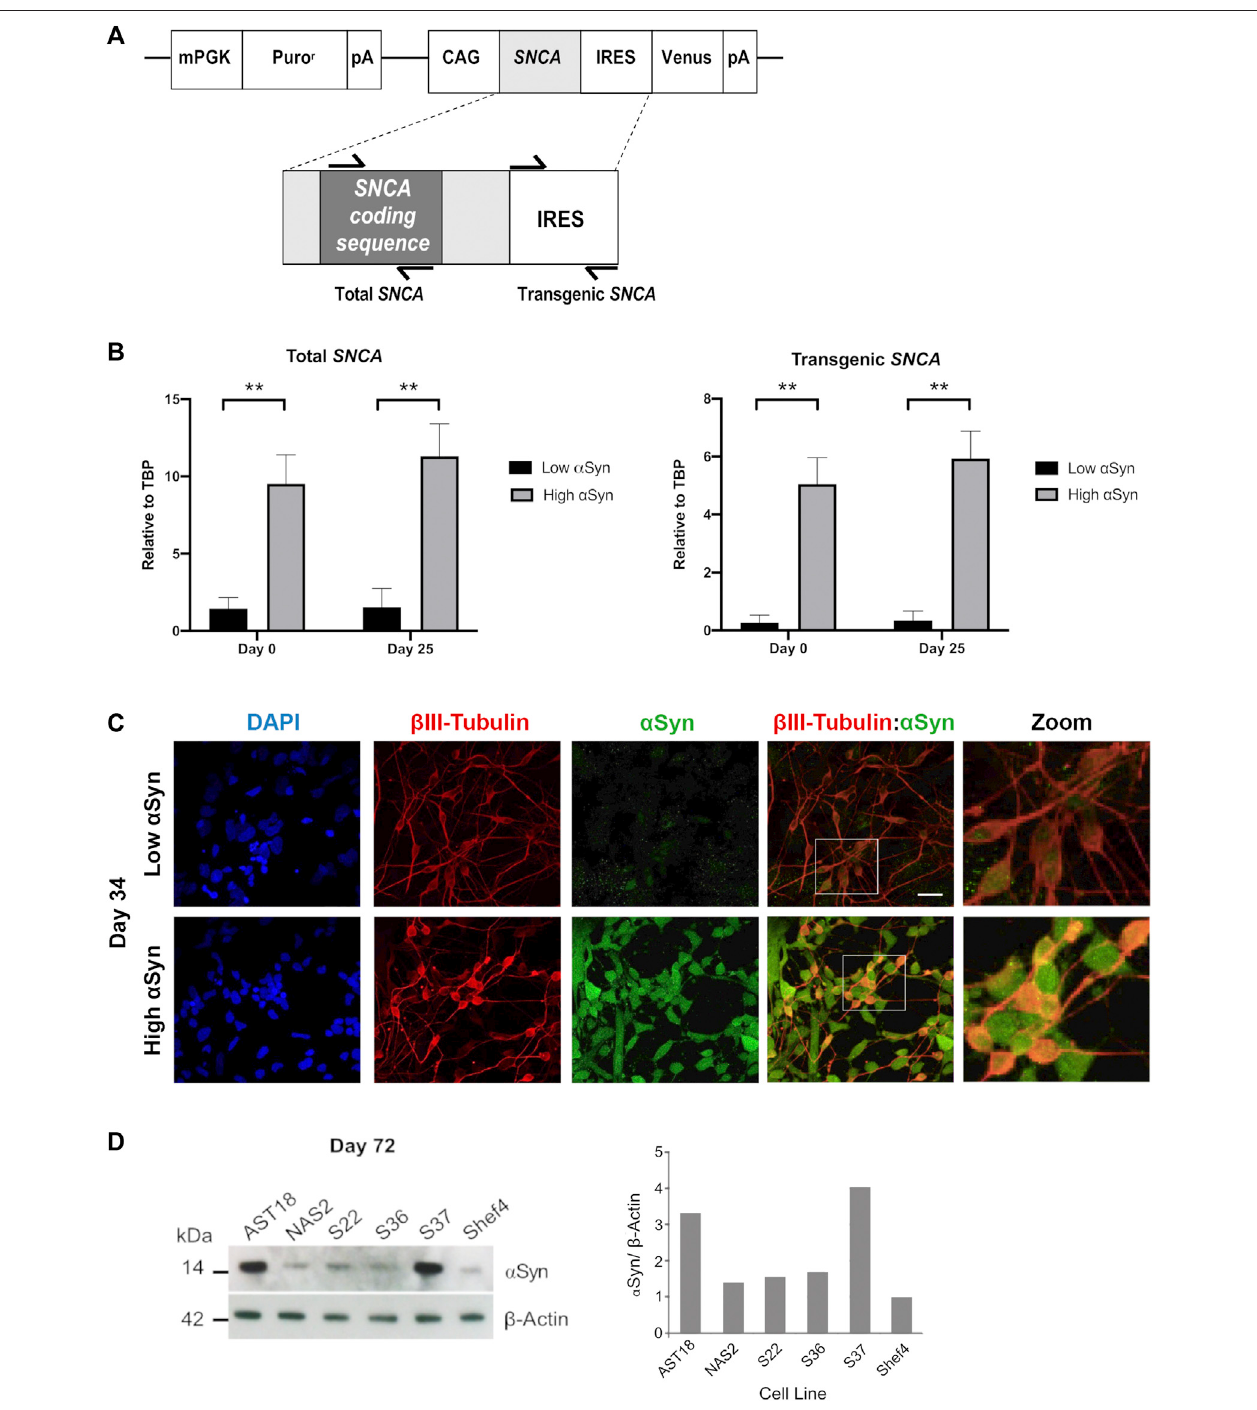
FIGURE 4 | Overexpression of α Syn is maintained during cortical neuron differentiation. (A) Schematic showing the regions of SNCA cDNA ampli fi ed to measure “ Total SNCA , ” and location of primers targeting the internal ribosome entry site (IRES) region to measure “ Transgenic SNCA ” levels. (B) Quantitative RT-PCR for total SNCA and transgenic SNCA expression forboth low α Synand high α Synsamplesat day 0 (self-renewing hESCs) and day 25 (immature differentiated cortical neurons). Mean expression levels were quanti fi ed relative to the expression of TBP and error bars represent SEM. N = number of biological replicates (differentiated cell line) and n = technical replicates (number of wells per cell line). For both total and transgenic α Syn, low α Syn ( N = 4, n = 4) and high α Syn ( N = 6 and n = 6). Statistical comparisons were performed using the Welch ’ s t -test (** = 2-tailed p < 0.01). (C) Representative immunocytochemistry images of differentiated neuronal cells (day 34) derived from transgenic Shef4 clonal lines S9 (low) and S37 (high), stained for DAPI (blue), β III-Tubulin (red), and α Syn (green). White box delineates the zoomed in area. Scale bar = 30 µm. (D) Western blot (left) for total α Syn and ß -actin in cortical neurons (day 72) differentiated from transgenic hESC and hiPSC cell lines. α Syn levels quanti fi ed in ImageJ (right) for all cell lines relative to expression in Shef4-derived neurons.